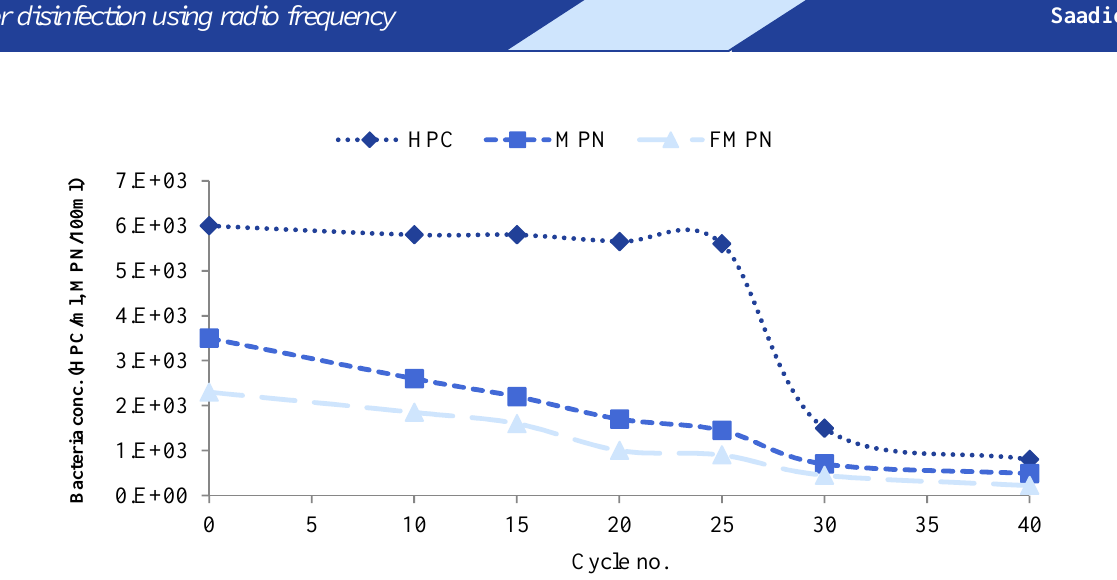
Figure 2. Total ciloforms, thermotolerant coliforms, and heterotrophic plate count removal trend after different cycles in absence of residual chlorine HPC: Heterotrophic plate count; MPN: Most probable number; FMPN: fecal coliforms most